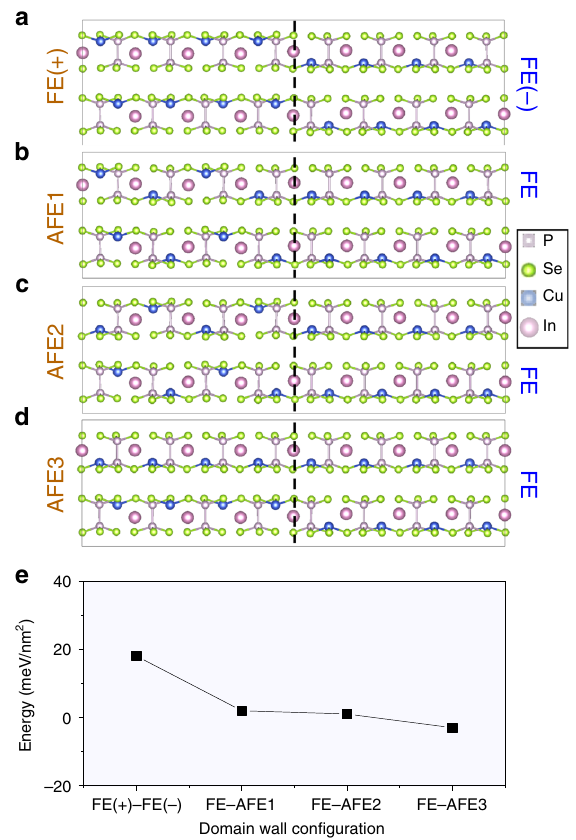
Fig. 5 Calculated structures of domain walls and phase boundaries in CuInP 2 Se 6 . a Ferrielectric domain wall (FE/FE). b Three kinds of antiferroelectric/ferroelectric boundaries, respectively AFE1/FE ( b ), AFE2/ FE ( c ) and AFE3/FE ( d ). e Corresponding boundary and wall energies. FE stands for ferrielectric and AFE for antiferroelectric